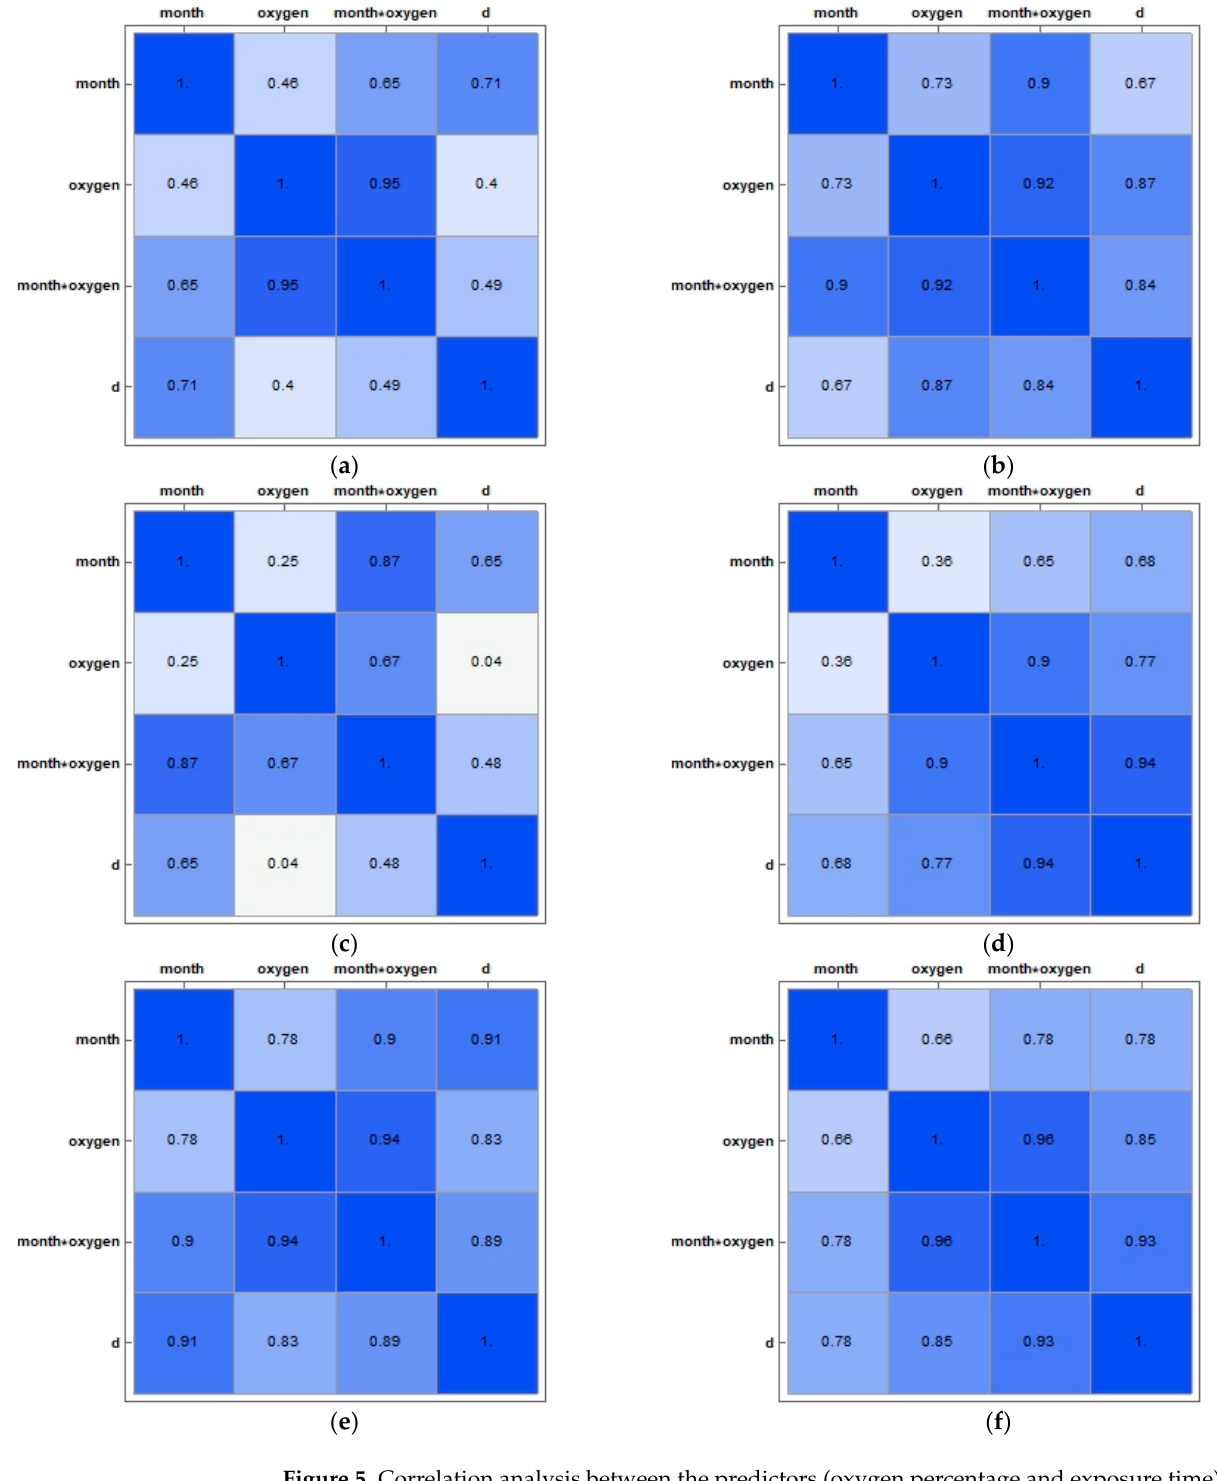
Figure 5. Correlation analysis between the predictors (oxygen percentage and exposure time) and response variable (corrosion depth): Influenced by air on NiTi1 ( a ) and NiTi2 alloys ( b ), influenced by tide on NiTi1 ( c ) and NiTi2 alloys ( d ), influenced by sea on NiTi1 ( e ) and NiTi2 alloys ( f ). Using a generalised regression model with the form shown in Formula (1),